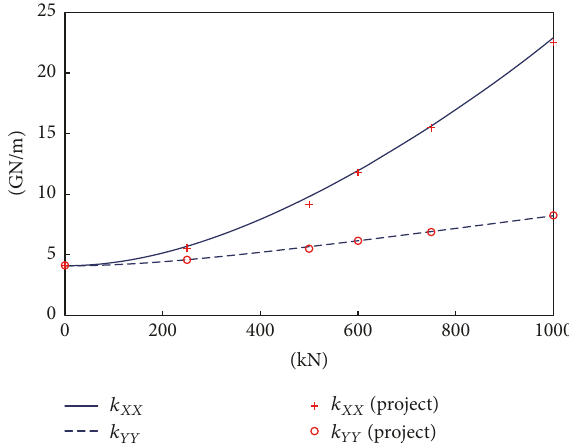
Figure 9: Upper journal bearing main stiffnessvalues ( 𝑘 𝑋𝑋 and 𝑘 𝑌𝑌 ) achieved with the proposed method (continuous and dashed lines) and calculated by the manufacturer during the project (“+” and “ ∘ ” marks), in relation to the radial static load in 𝑋 direction, for 𝜂 = 0.020 Pas and c = 200 𝜇